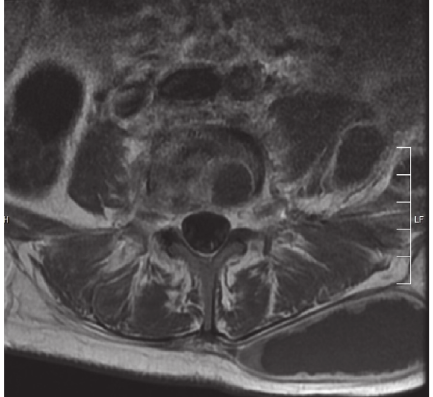
Figure 2: Axial view of MRI lumbar spine. T1 image with contrast depicting edema and erosive changes within vertebral body consis- tentwithdiskitisandosteomyelitis.Alsofiguredemonstratesabscess extending into ventral epidural